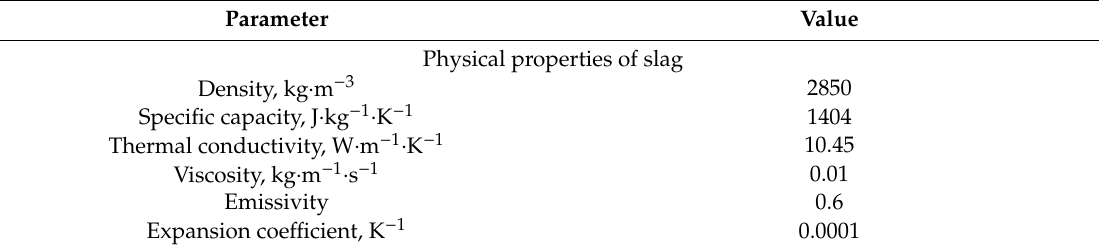
Figure 3. Flow diagram of the numerical simulation. Table 1. Parameters of the numerical